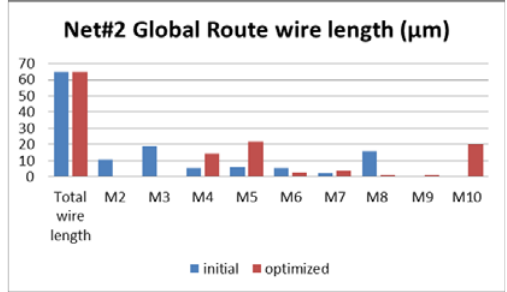
Figure 9. Net#2 global route wire length distribution.